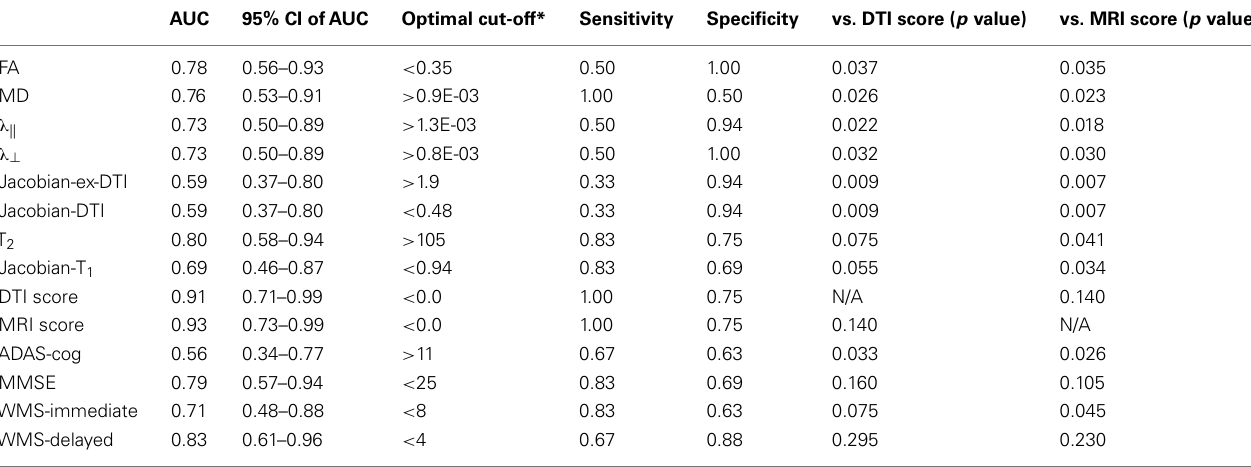
Table 1 | Result of the ROC curve analysis to separate aMCI-converter from aMCI-stable patients.